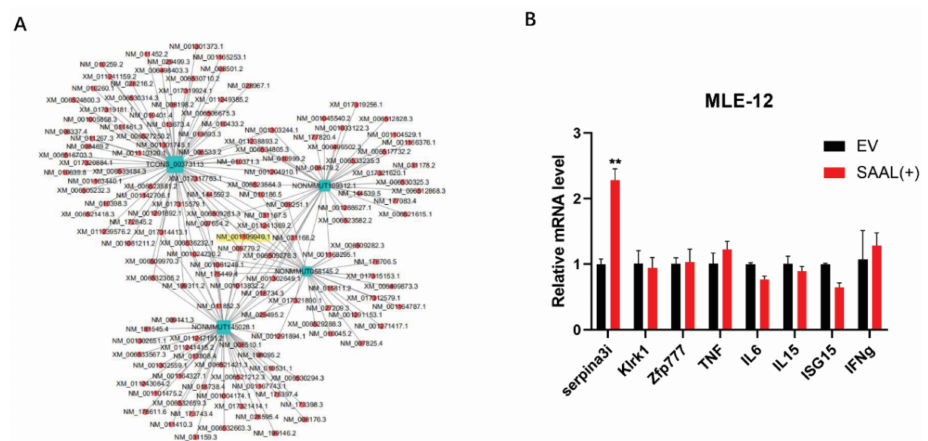
Figure 4. Bioinformatic analysis and RT-qPCR identified that Serpina3i is coexpressed with SAAL. ( A ) lncRNA-mRNA coexpression map. lncRNA was represented by a blue square, and mRNA was represented by a red circle. ID of Serpina3i was highlighted by yellow color. ( B ) RT-qPCR was performed to determine the levels of candidate mRNAs. The means for three independent experiments ± SD are shown ( n = 3; means and SD; ** p <